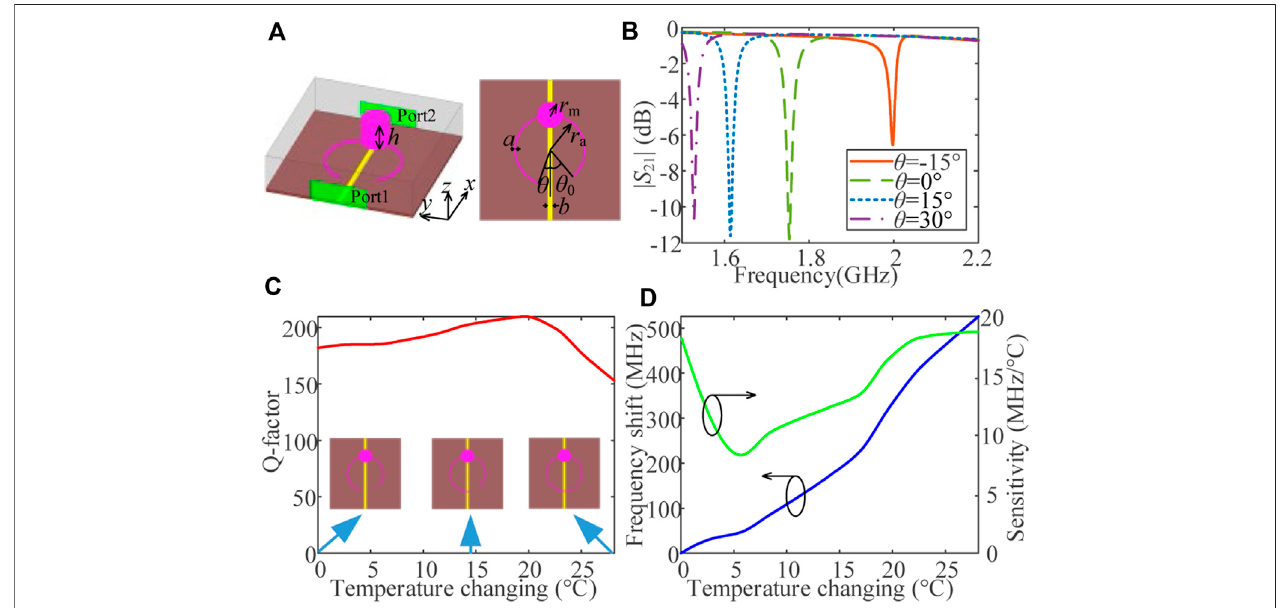
FIGURE 2 | (A) 3D view of the microstrip-line coupled Hg-Fano resonator with port setting in modeling environment and top view with parameters de fi nition, (B) numerical transmission curves under different parameter θ values, and (C,D) the calculated Q-factor, resonant frequency shift, and temperature sensing sensitivity as a function of temperature changings.